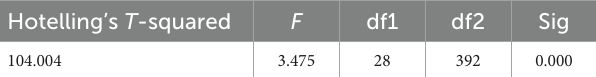
TABLE 8 Hotelling’s T -squared